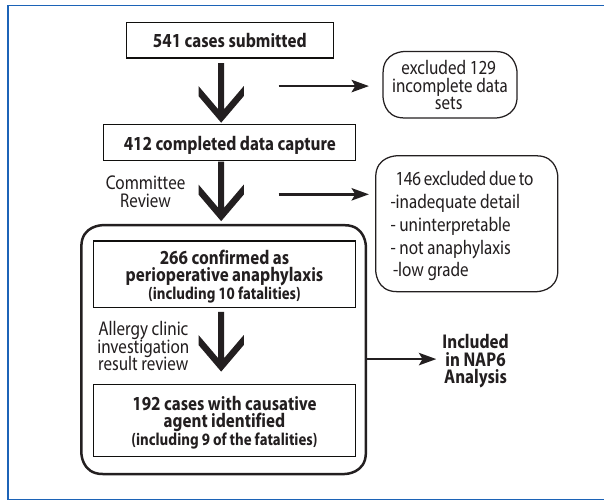
Figure 1: Summary of NAP6 Case Idntification